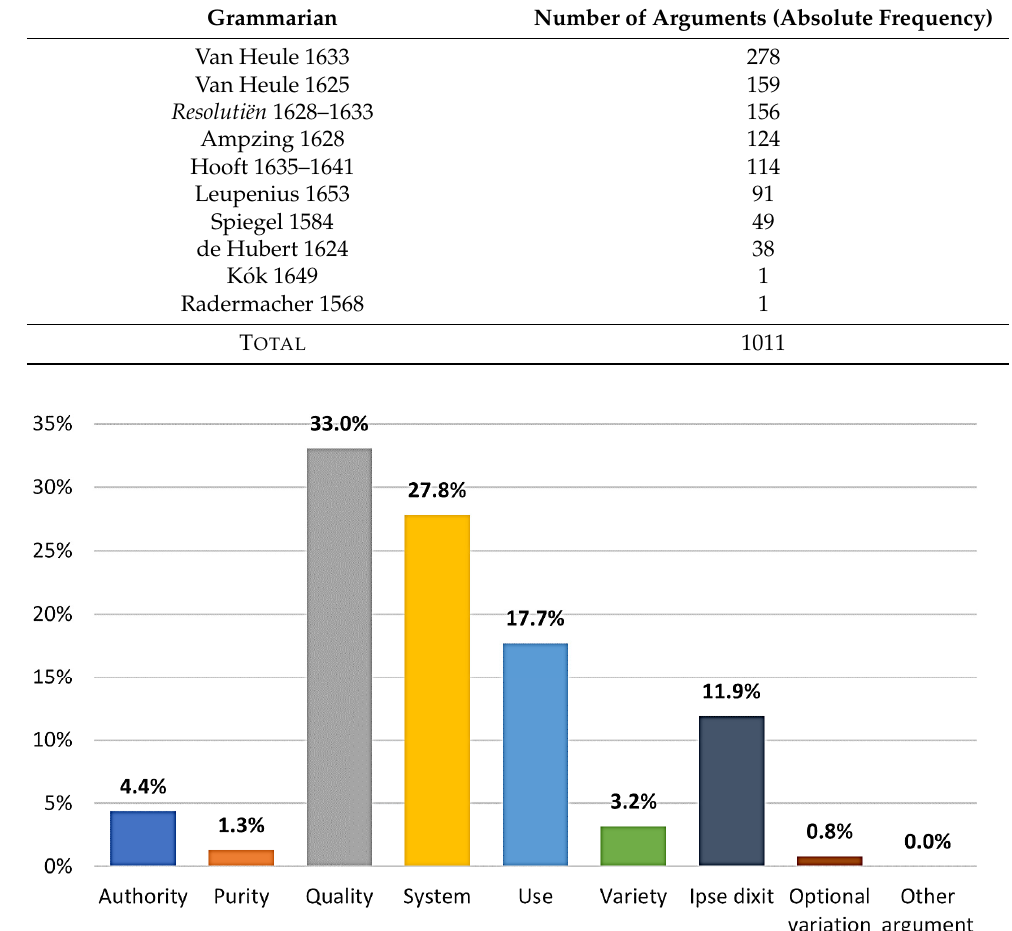
Table 2. Number of arguments per grammarian (in order of absolute frequency).